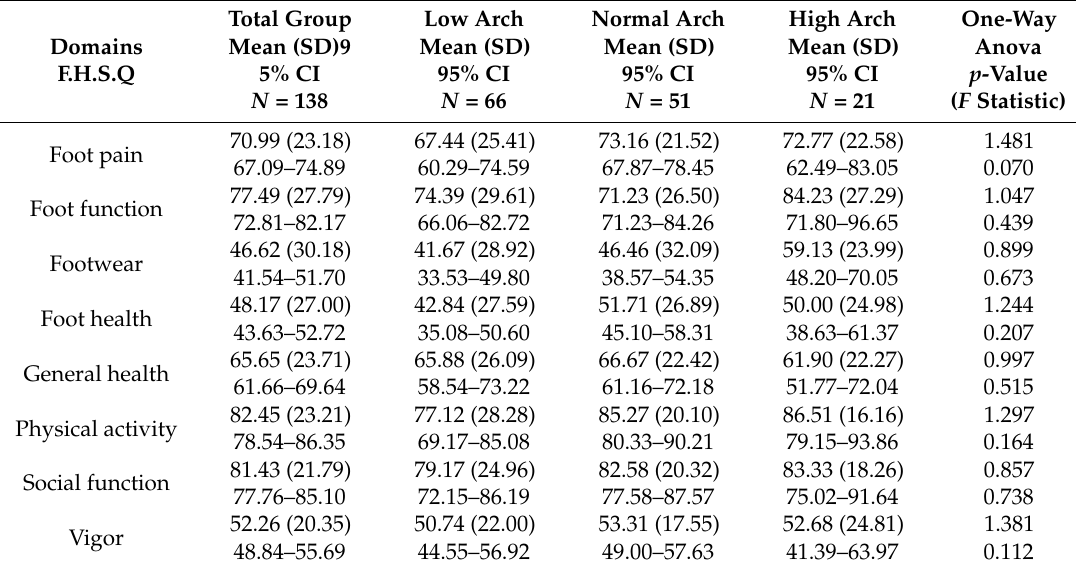
Table 3. Comparisons of F.H.S.Q scores for the cases and control